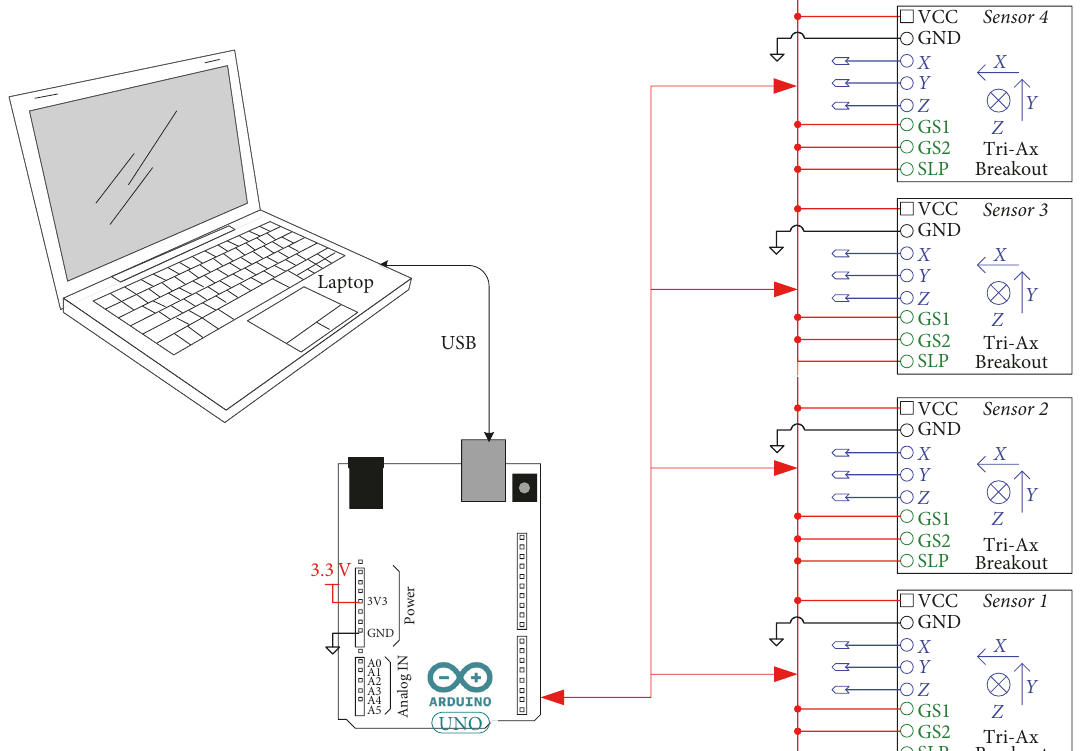
Figure 4: The accelerometer and signal conditioning system.